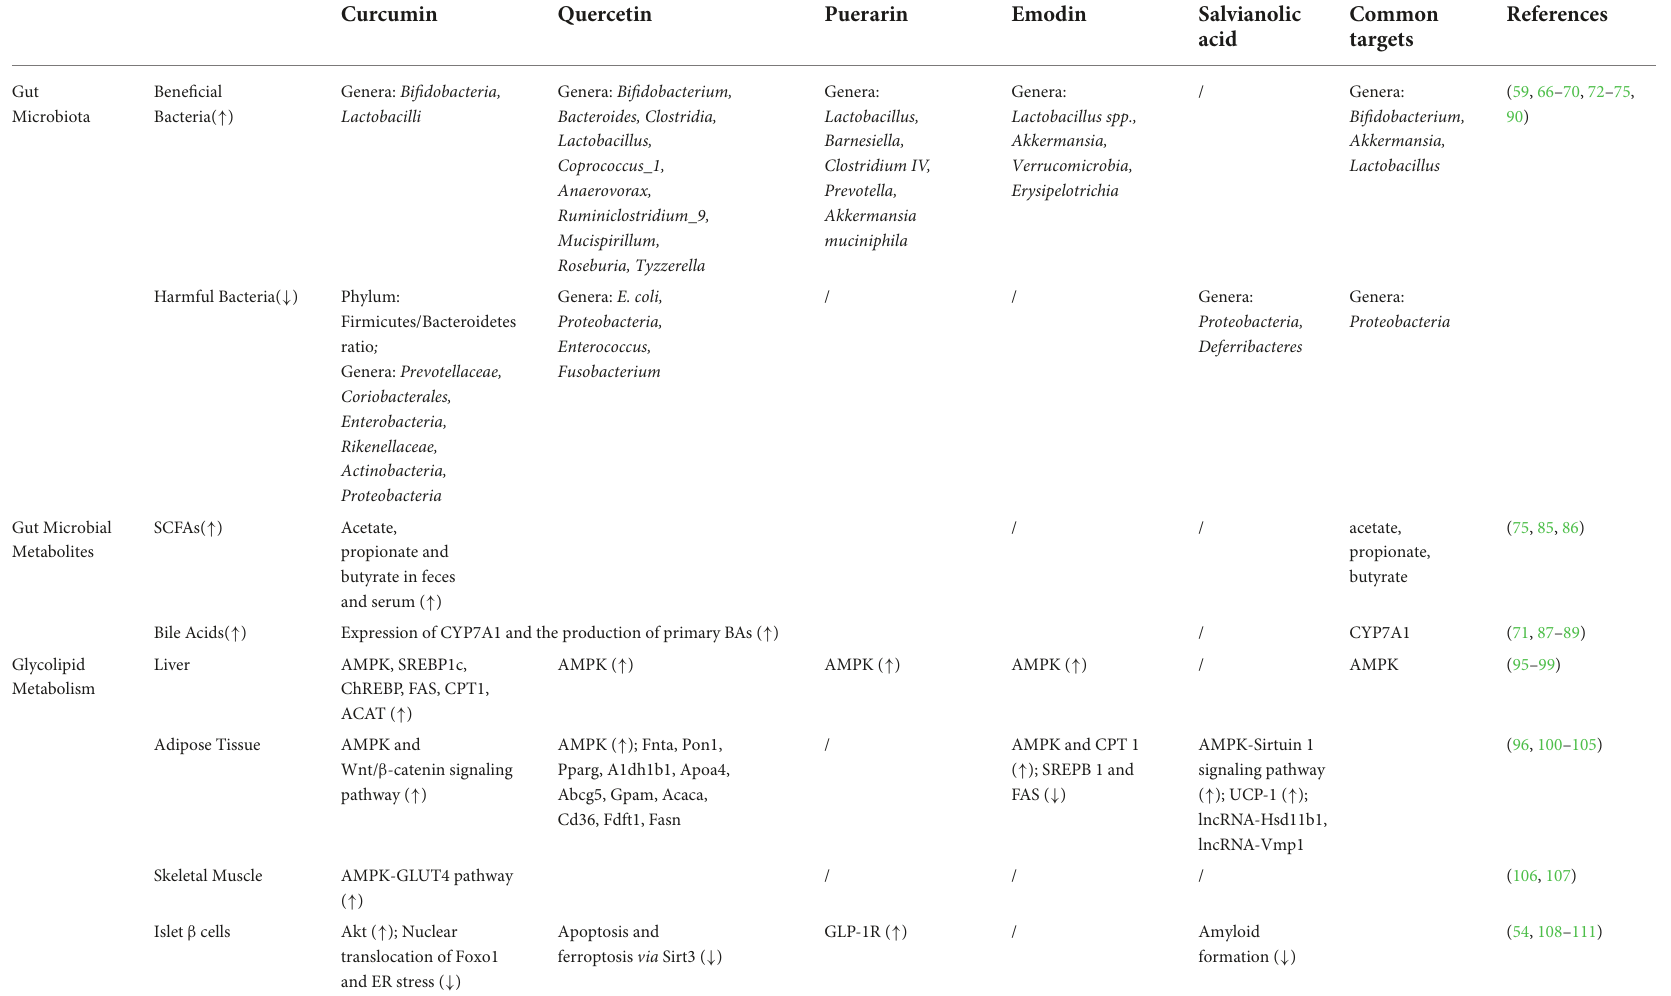
TABLE 2 Multiple targets of gut microbiota, metabolism, and immunity of natural polyphenols derived from CHM for the management of obesity and